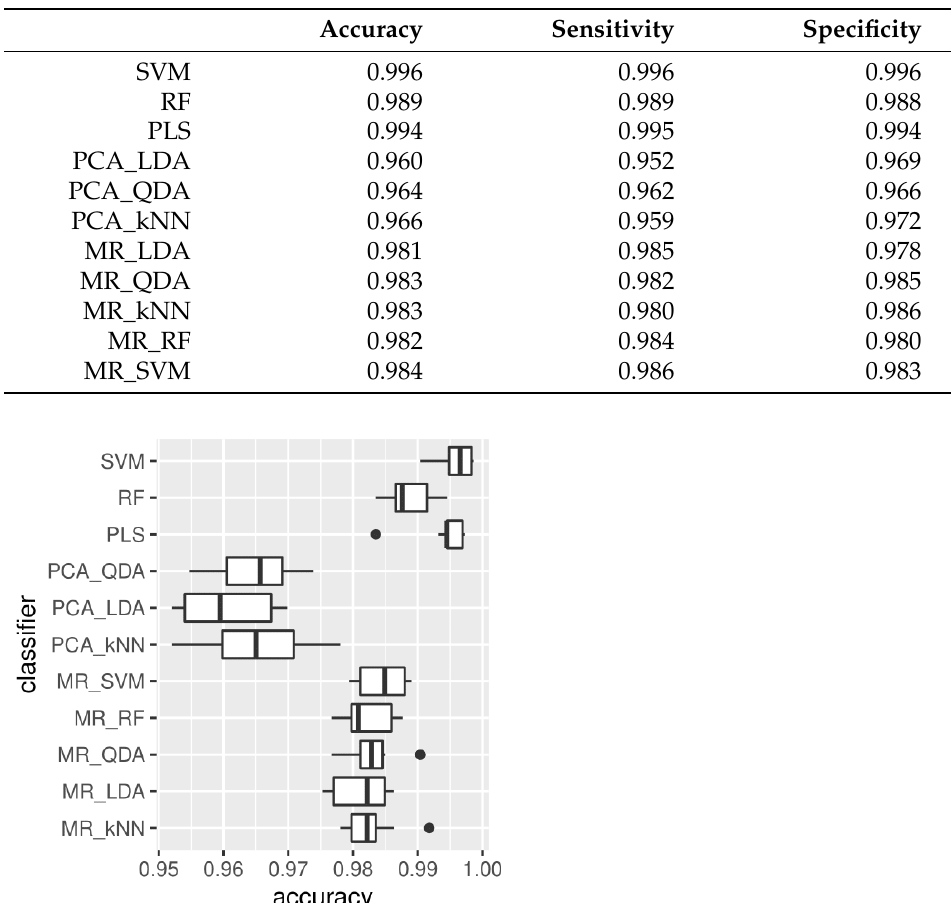
Table 1. Classification accuracy, sensitivity, and specificity for the 11 classifiers: LDA, QDA and kNN applied after pre-processing with PCA and MR. RF and SVM were trained after pre-processing with MR and on the entire data without any pre-processing for dimension reduction. PLS was applied without any pre-processing.